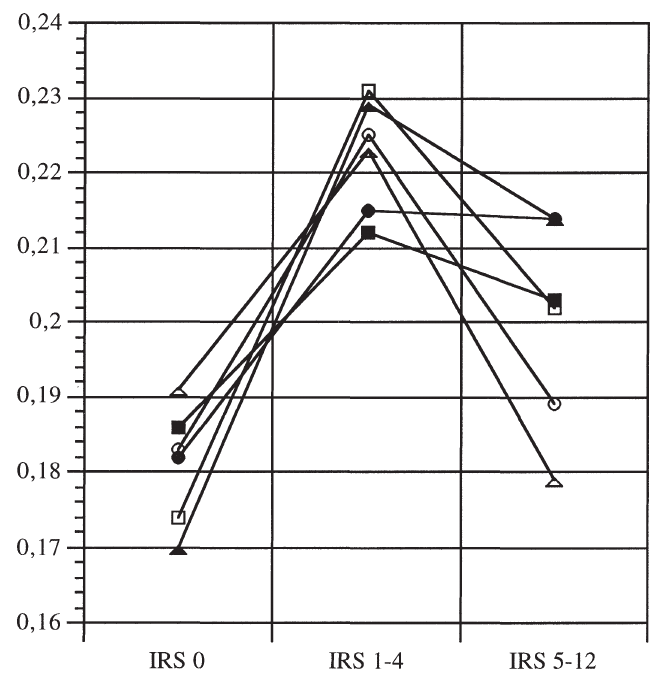
Fig. 1. Standard deviation of the percentage of heterochromatin optical density in the nuclear integrated optical density in breast cancers with different p53 expression in correlation to DNA ploidy, S-phase and G2M-fraction. IRS 0 . . . p53 negative tumours; IRS 1–4 . . . weakly p53 positive tumours; IRS 5–12 . . . strongly positive tumours. 1 peri-, di- and tetraploid; 2 aneuploid; ! S-phase < 5%; " S-phase > 5%; P G2M-fraction < 5%; Q G2M-fraction >